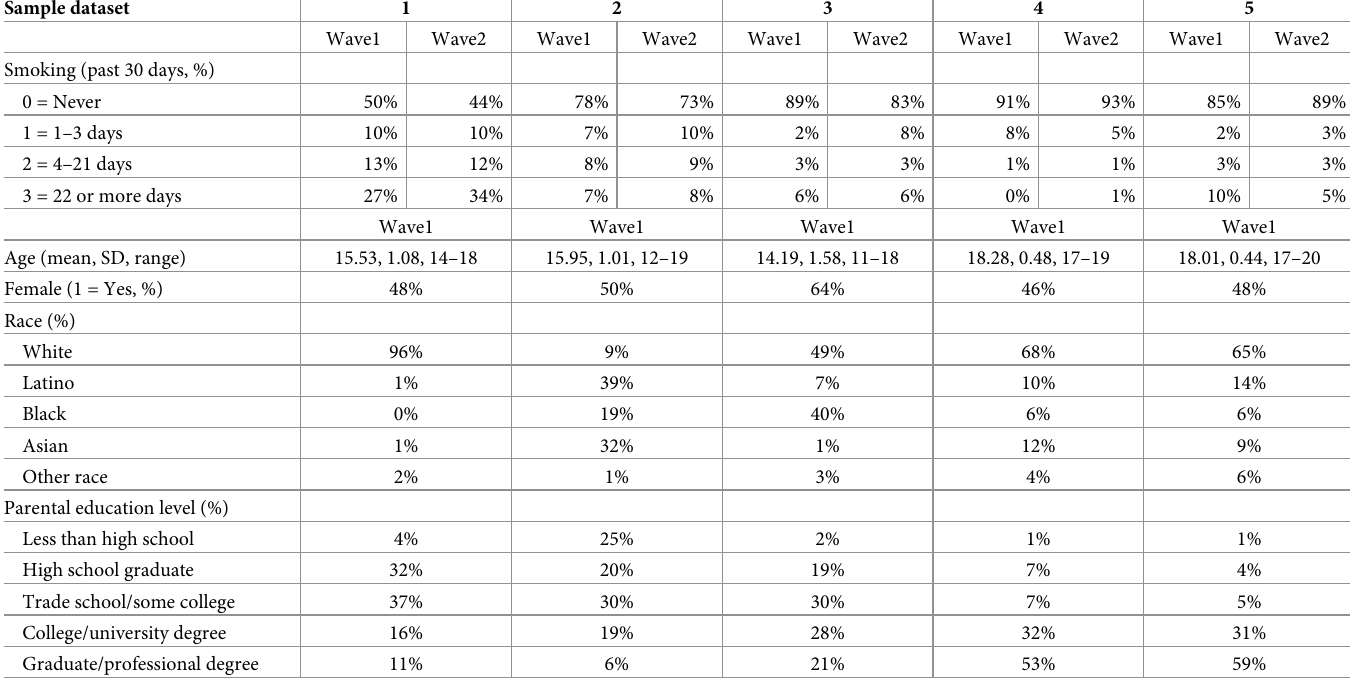
Table 1. Smoking levels and covariates from the five sample